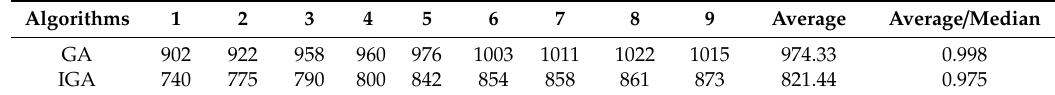
Table 1. The minimum of objective function.